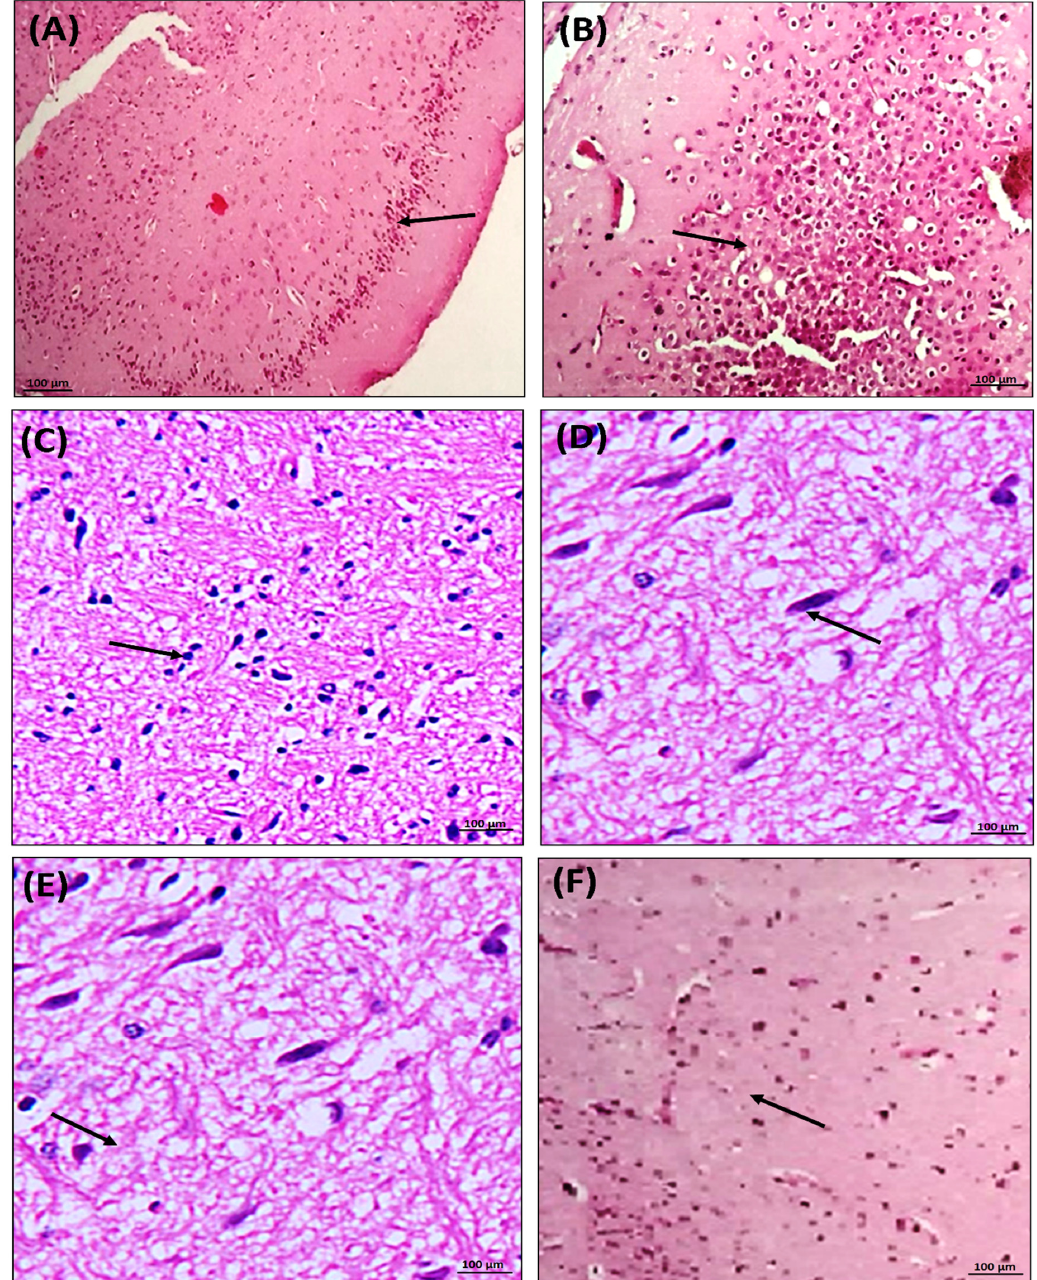
Figure 5. Antiepileptic effect of chondroitin sulfate on histomorphological changes marked by arrows against PTZ- and pilocarpine-induced seizures in mice. Scale bar of 100 µ m. ( A ) is a normal histology of the vehicle control group with intact and appropriately sized nuclei and neural cells. In the pilocarpine control group, there was a distortion of neurons and neuronal condensation, necrosis, and pyknotic nuclei in pilocarpine-administered mice compared to the negative control mice represented in Figure ( B ) compared with the vehicle control group. Figures ( E , F ) with the treatment of chondroitin sulfate (CS) and valproic acid against pilocarpine-induced neuronal damages were recovered, evidenced by retaining the normal histology with decreased distortion and death compared to the pilocarpine control group. Figure ( D ) represents the pentylenetetrazole control group, which revealed distortion of neurons, neuronal condensation, and necrosis in PTZ-administered mice compared to the vehicle control group. Figure ( C ) with the treatment of chondroitin sulfate (CS) and valproic acid against PTZ-induced neuronal damages were recovered, which is evidenced by retaining the normal histology with decreased distortion and death compared to the pentylenetetrazole control